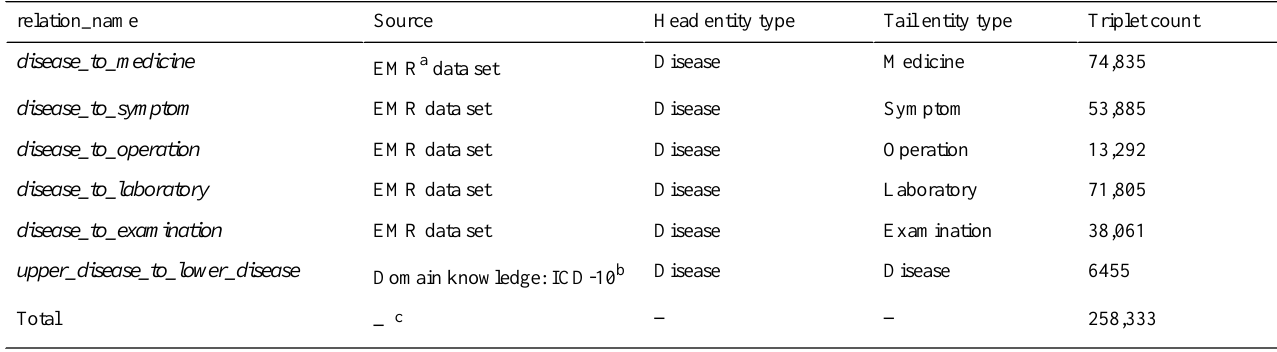
Table 2. Description and distribution of relationships in the medical knowledge